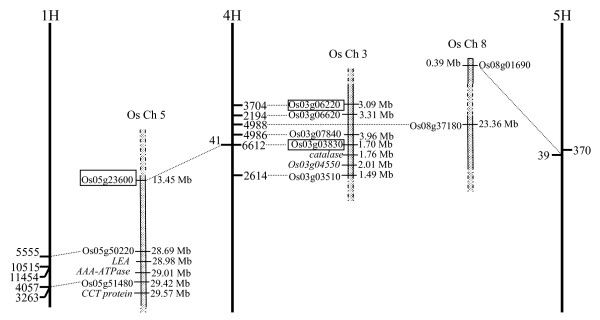
Polymorphic loci on barley genetic map. Polymorphic loci between Maythorpe and Golden Promise on barley genetic map and position of corresponding rice orthologs on the genome. The figure shows the polymorphic loci (14 unigenes) between the two genotypes detected by SNP analysis (solid line). The rice orthologs of these barley unigenes derived by BLAST hit to rice database are placed on the left of individual barley chromosomes (1H, 4H, 5H). The rice orthologs of barley genes identified by expression analysis (in italics) and from SFP analysis (boxed) are also shown. This illustrates the regions of haplotype polymorphism between Golden Promise and Maythorpe on barley chromosomes 1H, 4H and 5H.